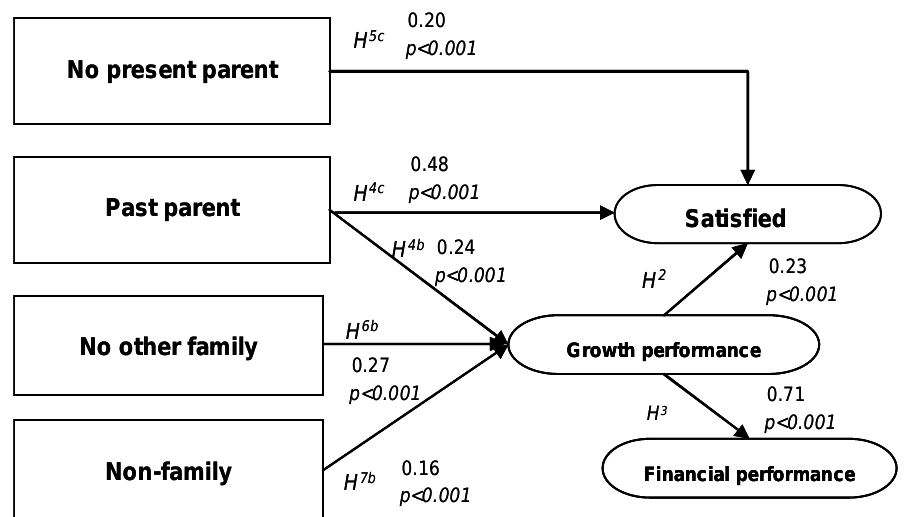
* Satisfied = Satisfaction with work and family relationships Figure 2 Model of family and non-family members influencing the level of Satisfaction with work and family relationships in Sibling Partnerships Significant positive relationships were found between Past parent involvement (path coefficient = 0.24, p<0.001) and Growth performance (hypothesis H 4b ), as well as between Past parent involvement (path coefficient = 0.48, p<0.001) and Satisfaction with work and family relationships (hypothesis H 4c